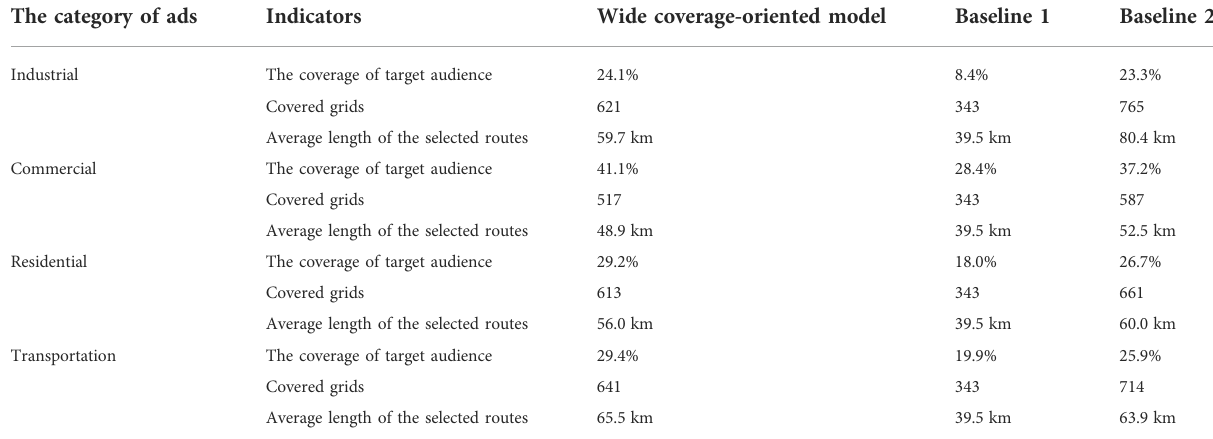
TABLE 2 Evaluation of the wide coverage-oriented model.